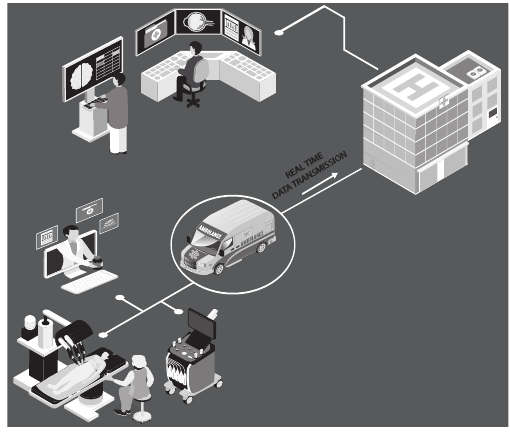
Figure 8. Data transmission in smart